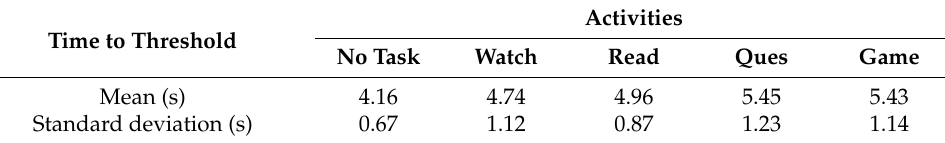
Figure 11. Time cost for the vehicle back to the safe position. Table 3. Time to threshold for all